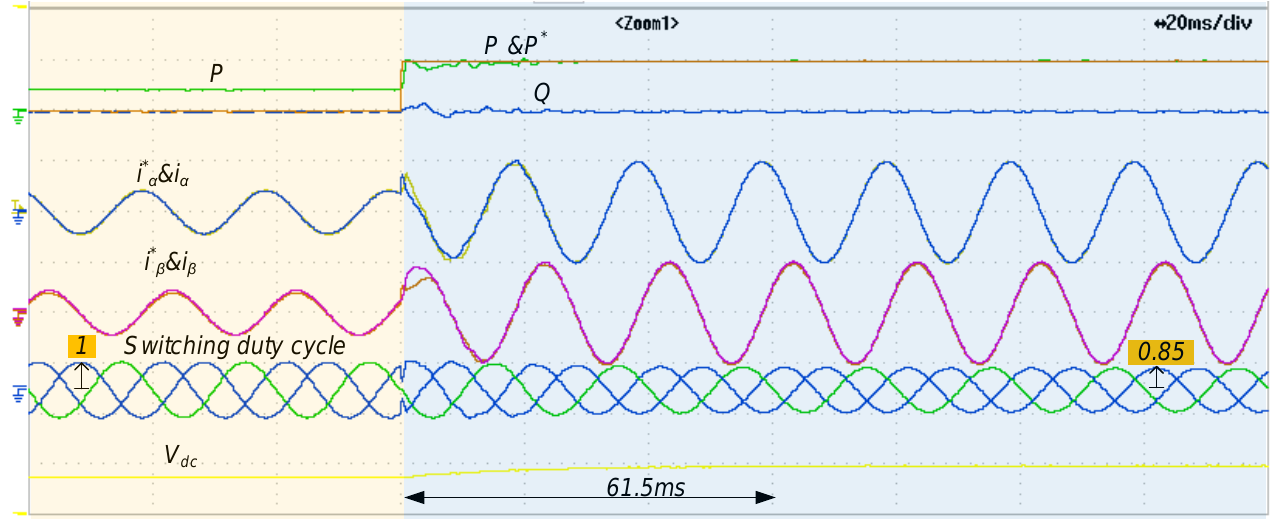
Figure 12. Real-time simulator results: active power reference step-up for BES-P2G. From top: active power reference ( P* , 10 kW/div), active power ( P , 10 kW/div), reactive power ( Q , 10 kVAR/div), actual and reference currents ( 𝑖 𝛼𝛽∗ &𝑖 switching duty cycle, DC link voltage ( V dc , 700 V/div).